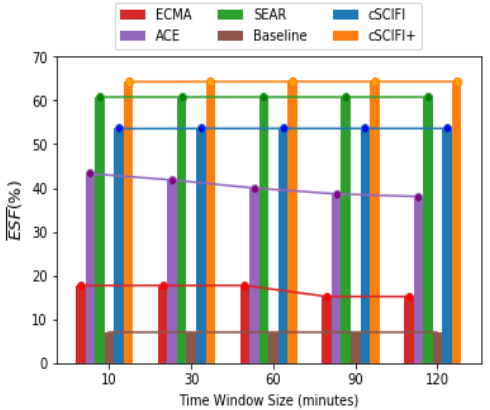
Figure 3. Normalized energy saving factor for different time window